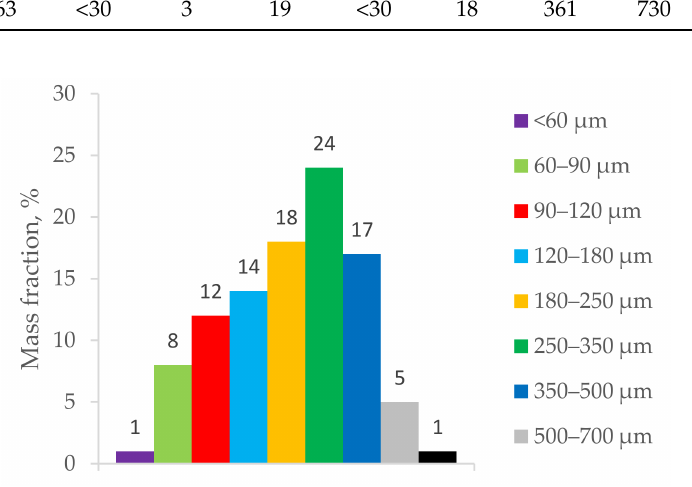
Figure 1. Fractional composition of zirconium